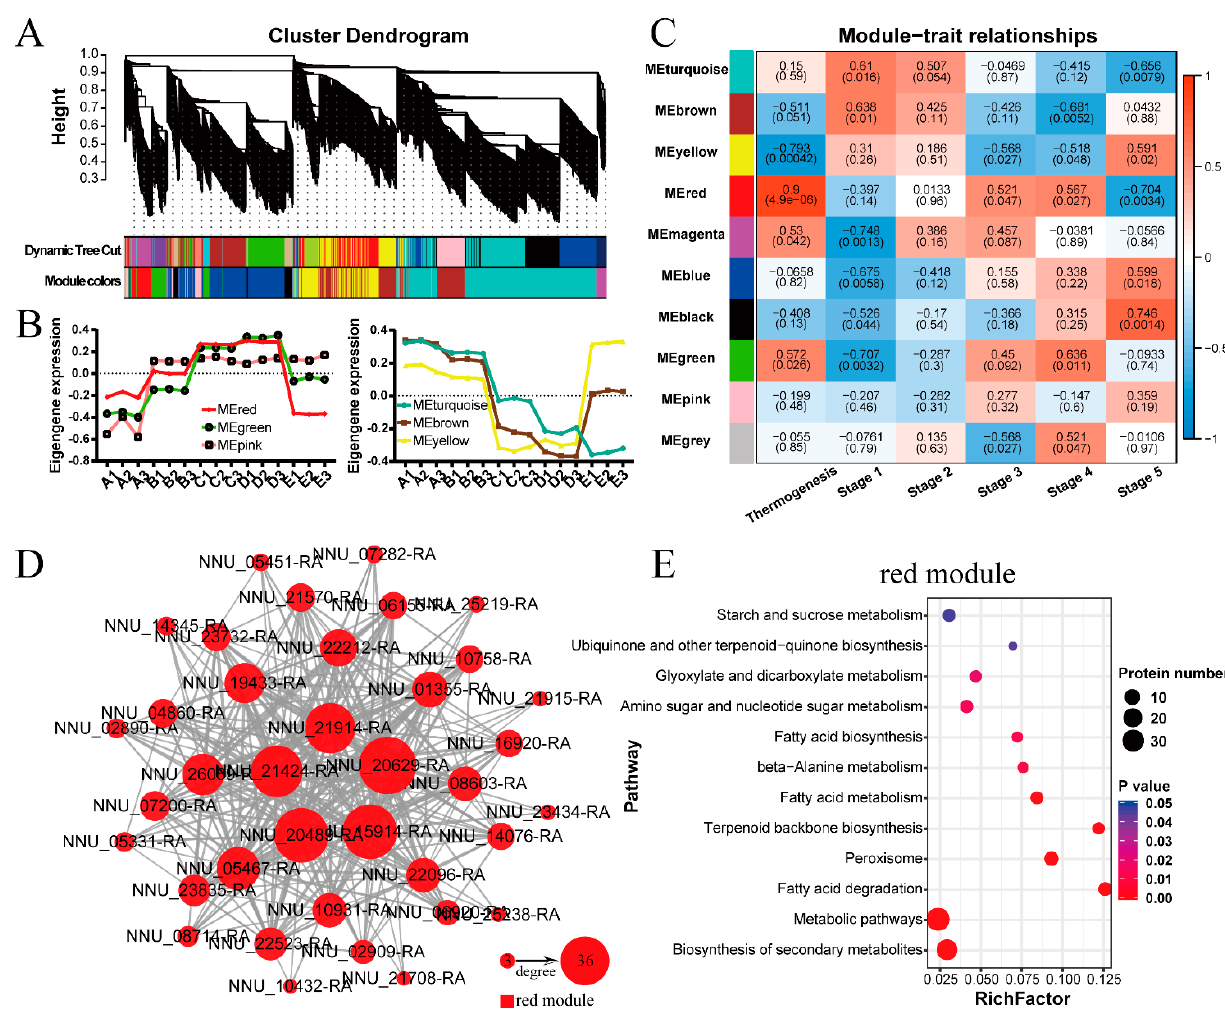
Figure 7. Weighted gene co-expression network analysis: ( A ) Hierarchical clustering dendrogram shows co-expression modules that are color-coded. ‘Dynamic Tree Cut’ represents initial modules. Module colors represent the final modules. Each branch in the hierarchical tree or each vertical line in color bars represents one protein. ( B ) Temporal expression patterns of different modules. Eigengene is the first principal component of a given module, which can be considered a representative of the protein profiles in a module. A, B, C, D, and E represent stage 1, stage 2, stage 3, stage 4, and stage 5, respectively. Each stage includes three replications. ( C ) Module trait correlation plot. Each row represents one module. Each column represents one trait attribute. The blue color represents negative correlation and the red color represents positive correlation. ( D ) The co-expressed proteins network of the red module with edge weight ≥ 0.52. The edge numbers of the proteins range from 3 to 36. ( E ) KEGG enrichment analysis of the proteins in the red module.